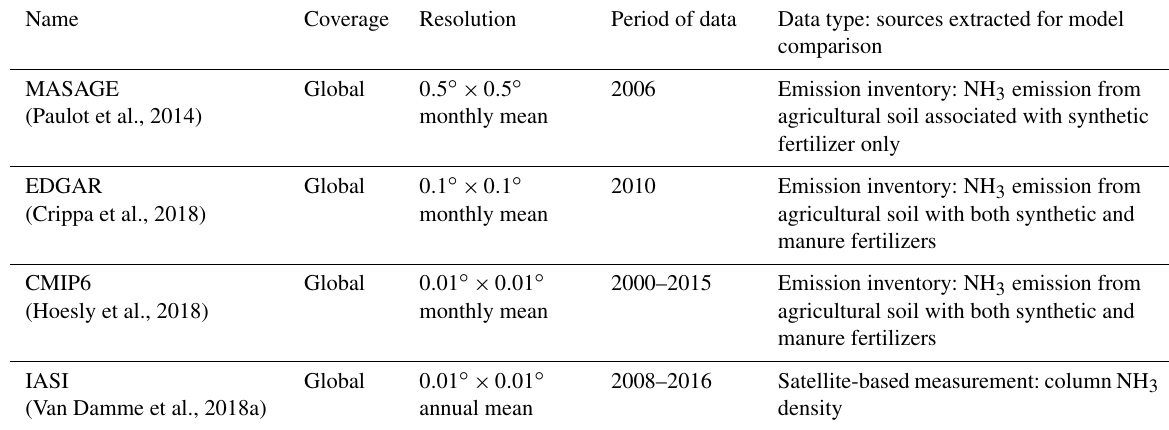
Table 2. Details of observations and emission inventories used in this study for model comparison and